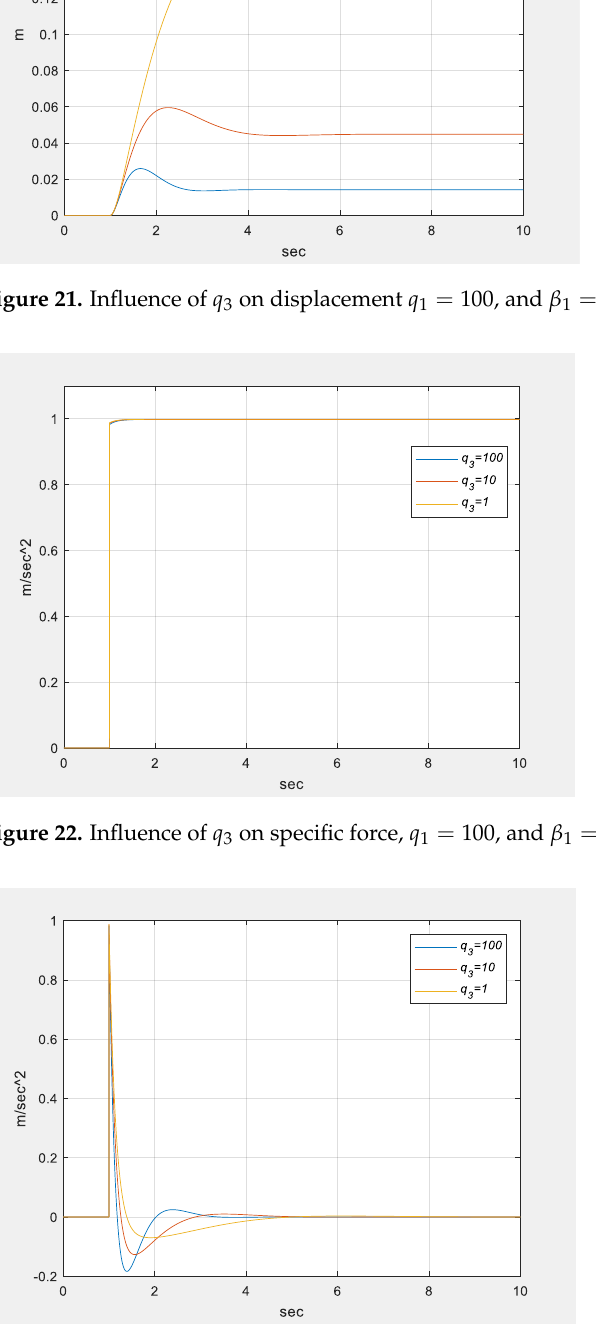
Figure 23. Influence of 3 q on acceleration 𝑎 𝑥 , 100 q = , and 1 = .